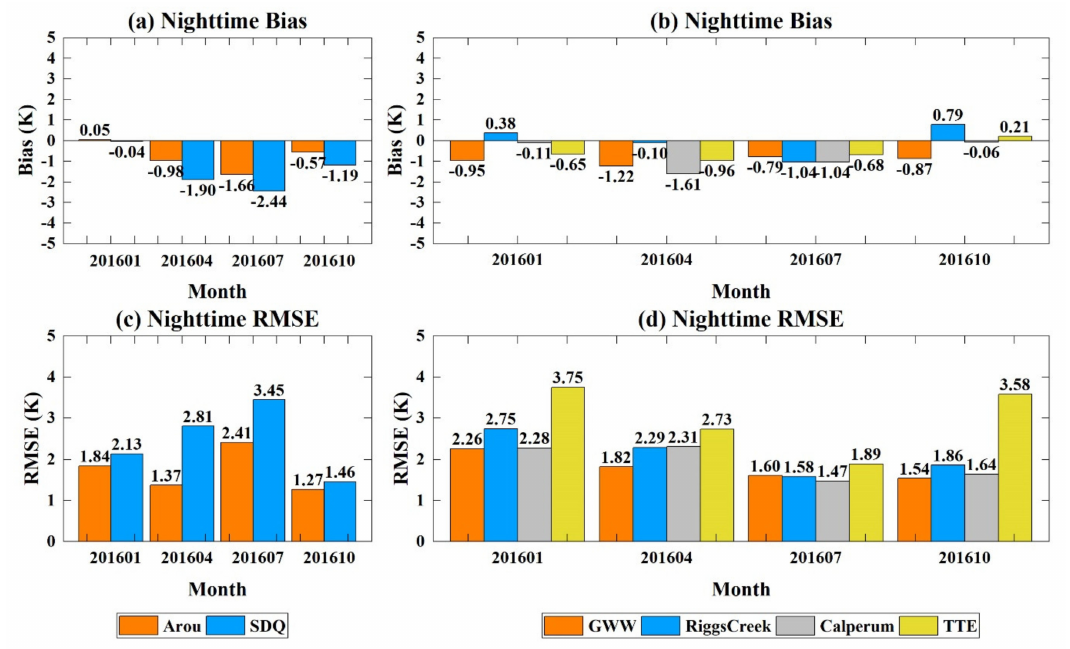
Figure 4. The biases and root-mean-square errors (RMSEs) of the LST di ff erences between AHI LSTs and in situ LSTs in di ff erent months during the nighttime for the T-based